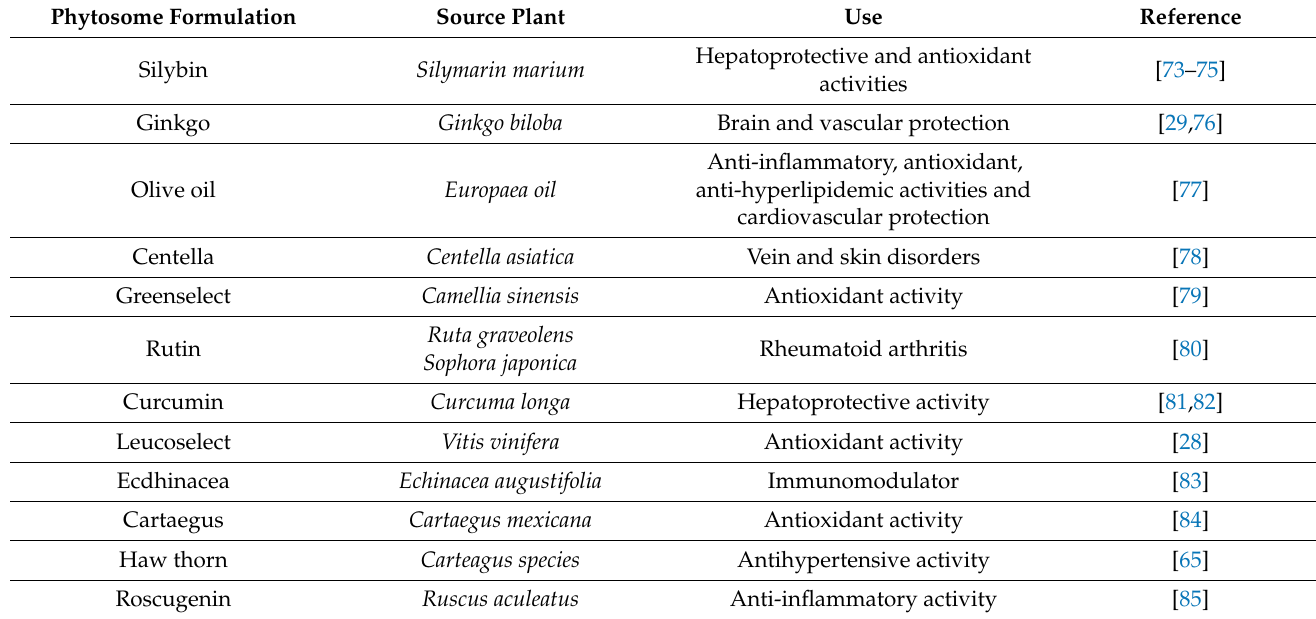
Table 1. Phytosome-based bioactive phytochemicals products available on the market. Phytosome